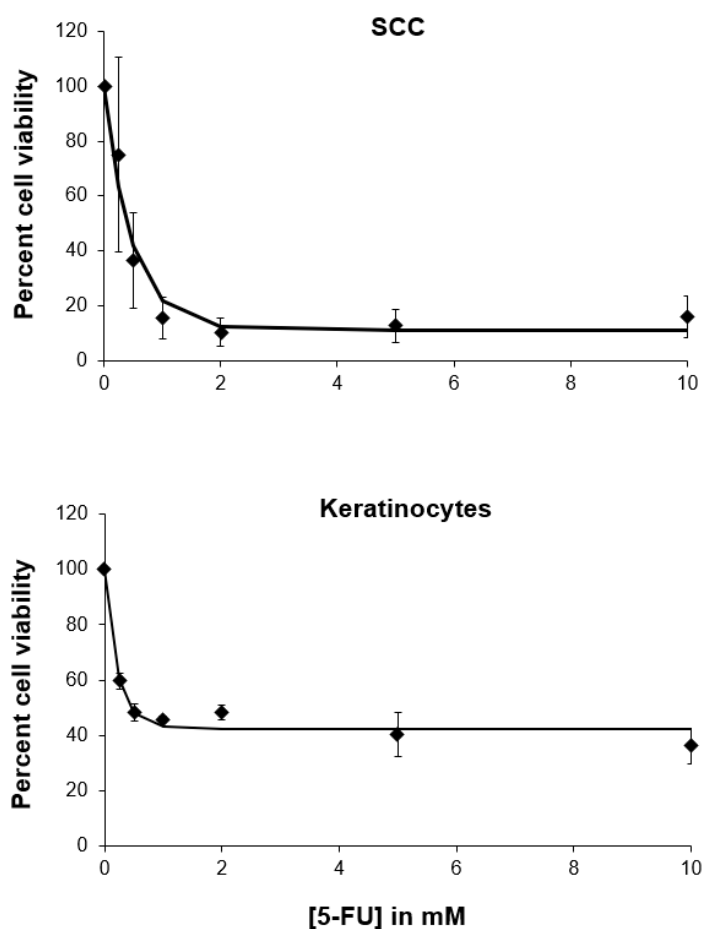
Figure 6. Dose-responses with the treatment of 5-FU for a 48-h continuous exposure.